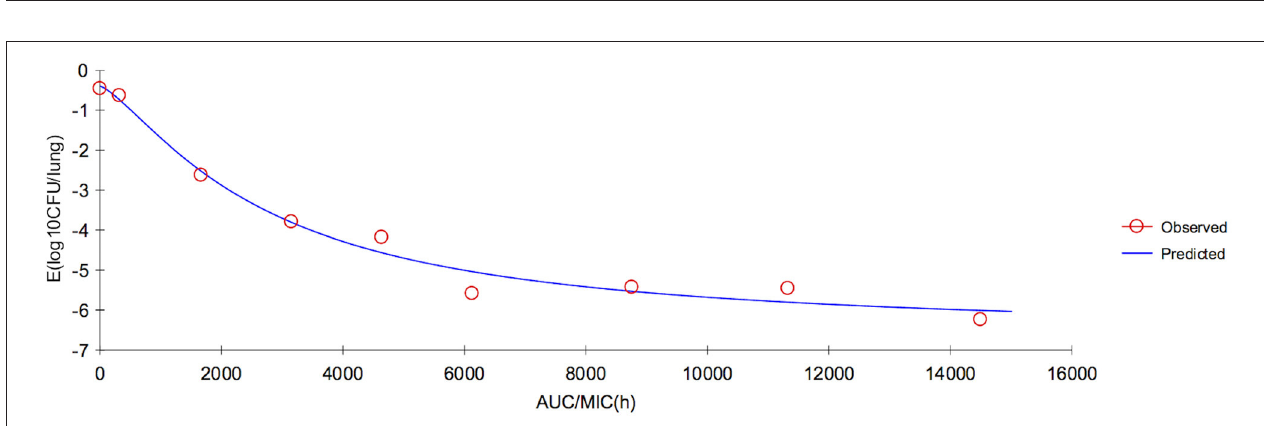
FIGURE 4 | Sigmoid E max relationship between anti- Haemophilus parasuis effect ( E , log 10 CFU/serum) and in vivo AUC 168 /MIC ratio against H. parasuis in the serum of guinea pigs.